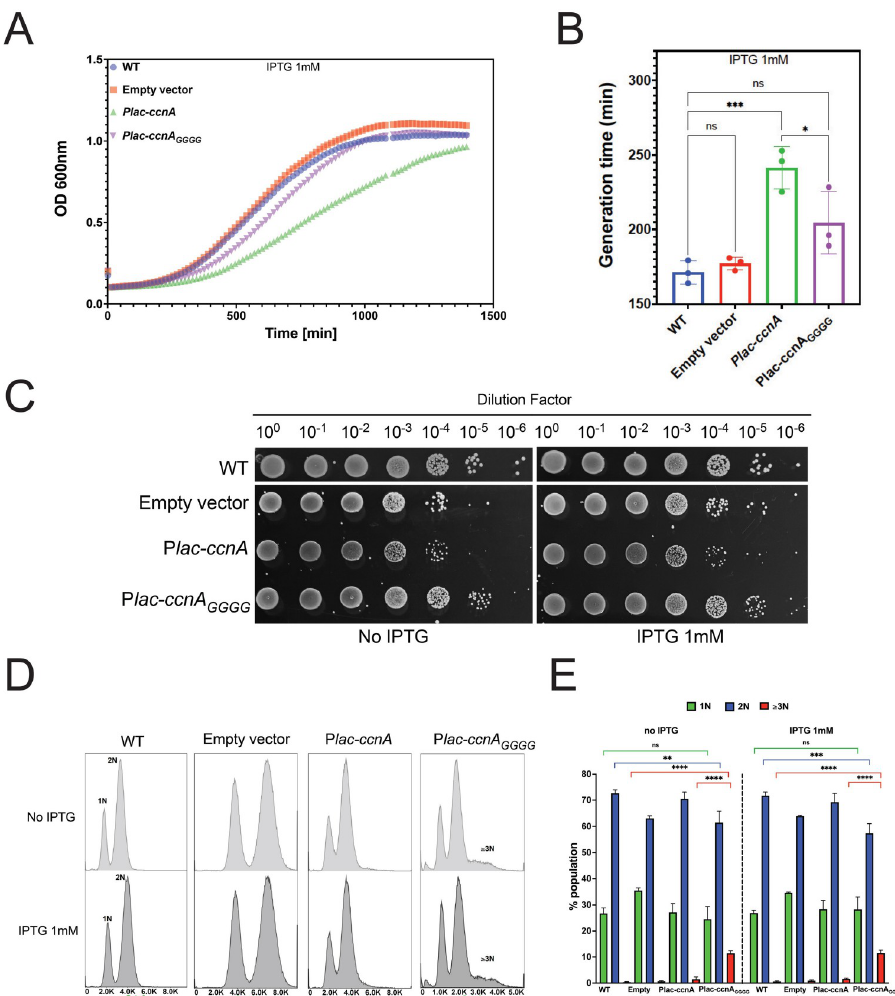
Fig 6. CcnA Loop A mutant shows attenuated cell cycle defects. (A) Growth curves following the expression of CcnA mutated in its Loop A (P lac-ccnA GGGG ). WT cells and WT cells carrying either an empty pSRK (empty vector) or a pSRK with ccnA under the control of an inducible P lac promoter ( P lac-ccnA) or Plac-ccnA mutated in its GGGG loop A were grown overnight in PYE without IPTG. A volume of 200 μ L of cells back-diluted from stationary phase cultures to an OD 600nm = 0.02 were grown on 96 wells in PYE supplemented with 1 mM IPTG. Cell growth was monitored overnight with a Spark-TM at 30˚C and a shaking (orbital) amplitude of 6 mm and a shaking (orbital) frequency of 96 rpm. Results are shown as mean N = 3 biological with 3 technical replicates. Raw data are provided in S7 Table. Note that all growth curves data of Figs 2, 6, and S9 were acquired in the same days of their respective biological replicates and compared to each other. ( B) Determination of the doubling time of cells expressing P lac- ccnA GGGG . Doubling times of cells from (6A) were calculated by using the exponential growth equation (nonlinear regression) (Prism GraphPad 9.1.2). Statistical analysis was performed using ANOVA with a Brown–Forsythe and Welch test with a Dunnett’s multiple comparisons test. ns, difference not significant, � : p.val = 0.0396 ��� : p. val = 0.0009. Raw data are provided in S7 Table. ( C) WT cells, WT cells carrying an empty vector, Plac-ccnA or Plac- ccnA GGGG were grown overnight in PYE at 30˚C and diluted to an OD 600nm = 0.6. Samples were then serially diluted (10 0 –10 − 6 ), and 4.5 μ L of each dilution were spotted on a PYE-Agar plate with or without IPTG 1 mM and incubated at 30˚C. WT cells without plasmid were used as negative control. ( D) Flow cytometry profiles after SYTO 9 staining showing DNA content of WT cells, WT cells carrying either an empty pSRK (empty vector) ccnA under the control of a Plac promoter (P lac-ccnA ) or ccnA Loop A variant ( Plac-ccnA GGGG) grown in PYE until OD 600nm = 0.3. Then, induction of P lac-ccnA or P lac-ccnA was made by addition of IPTG 1 mM 30 min. Cells without induction were GGGG grown for an additional 30 min as a control of growth phase. A total number of 300,000 particles were analyzed by flow cytometry. ( E) Proportions of cells harboring 1N, 2N, and � 3N DNA in the population were analyzed by gating the histograms in (E). Data are representative of 3–5 biological replicates. Statistical analyses were carried out using ANOVA Tukey test. ns, difference not significant, �� : p.val < 0.01, ��� : p.val < 0.001, ���� : p.val < 0.0001. CcnA, cell cycle noncoding RNA A; WT,